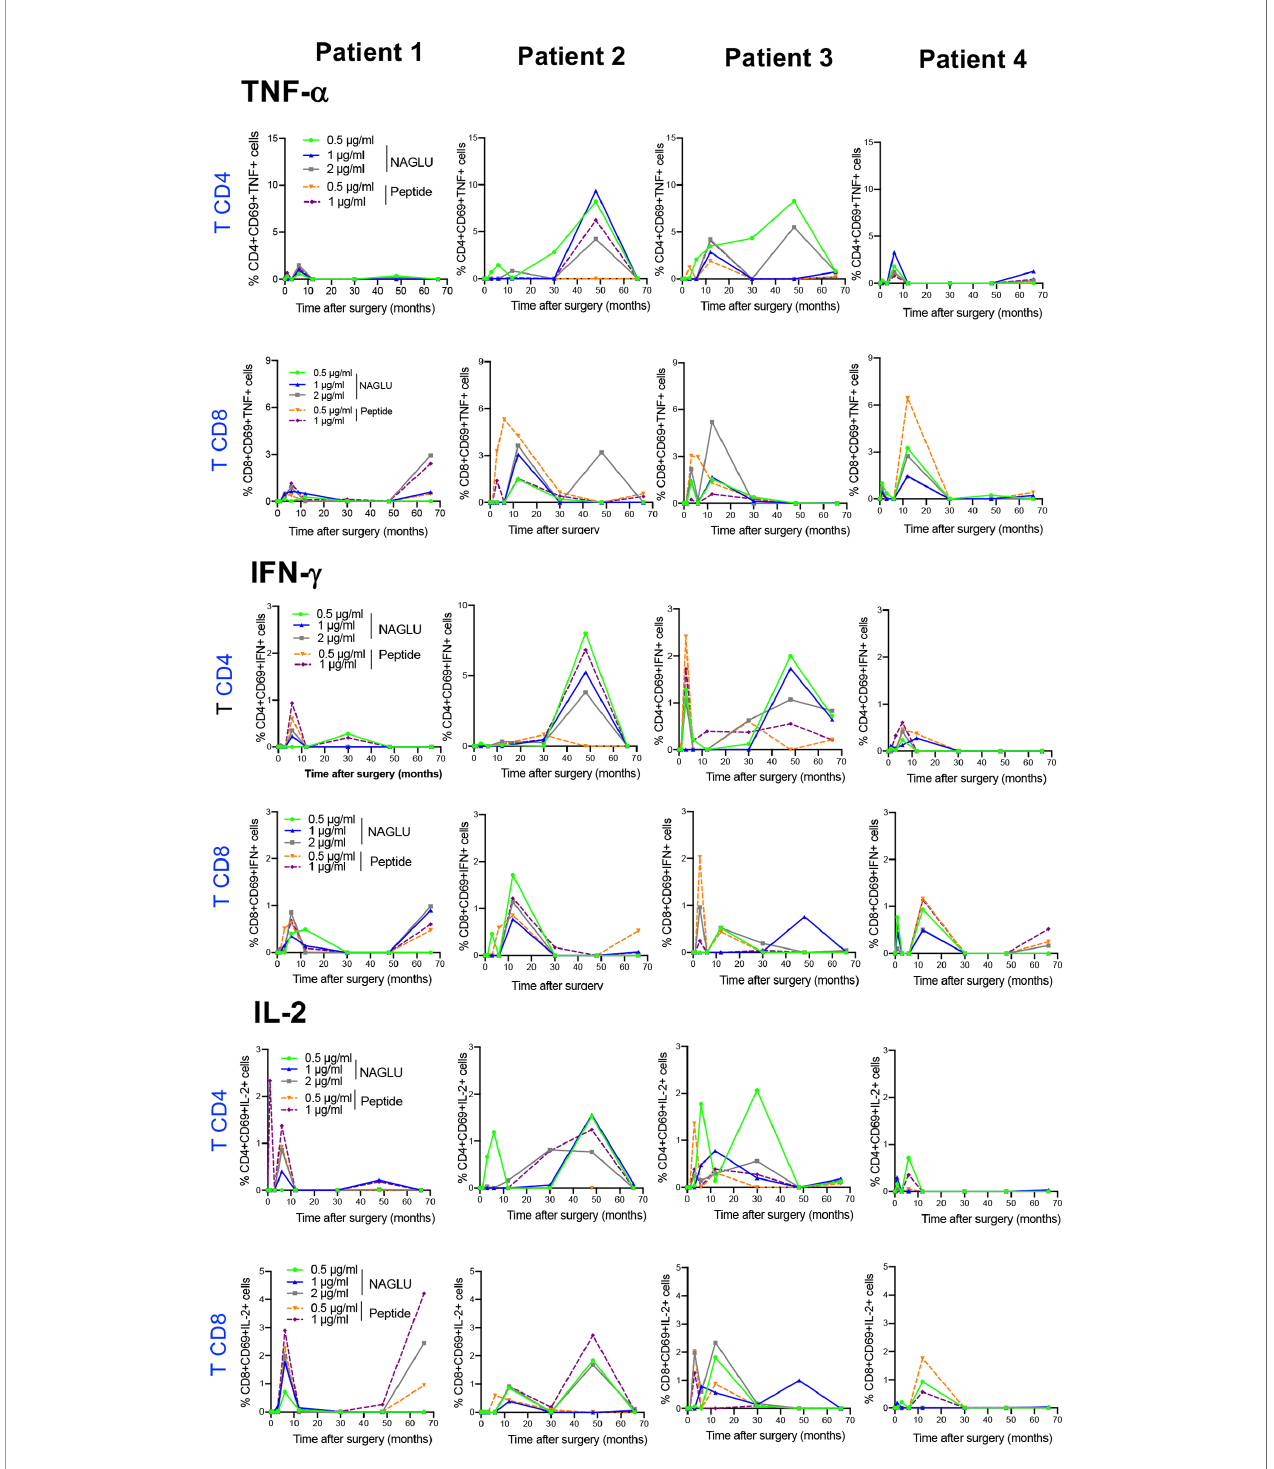
FIGURE 4 | Time course evolution of ex-vivo NAGLU-speci fi c cytokine expressing CD4 + and CD8 + T cells. Whole blood was stimulated for 6 h at indicated concentrations of NAGLU or the peptide, and speci fi c CD4 + and CD8 + T-cell responses were measured using an intracellular cytokine staining assay. For each patient, the percentage of NAGLU-speci fi c CD69 + CD4 + or CD8 + T cells expressing TNF- a , IFN- g or IL-2 is plotted at baseline (BL) and 1, 3, 6, 12, 30, 48 and 66 months after